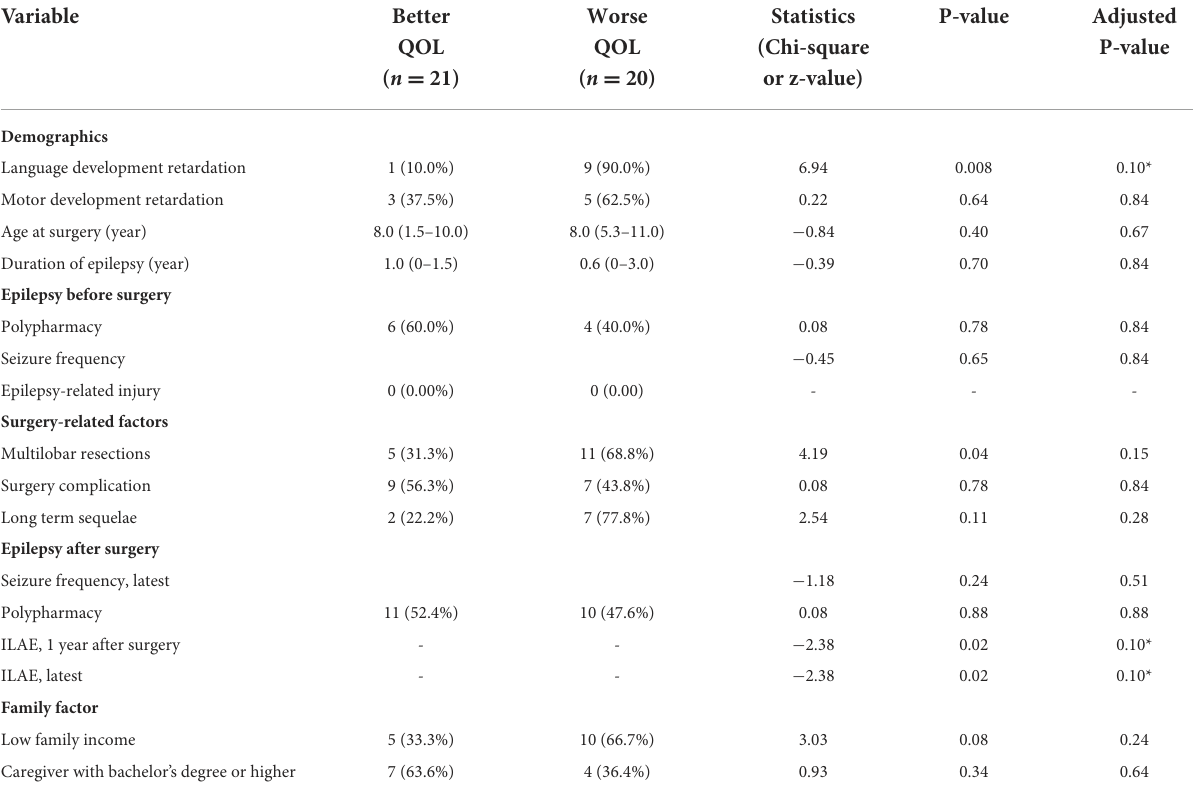
TABLE 2 Variables associated with a meaningful, clinically important change of QoL in children with residual seizure after resection surgery.